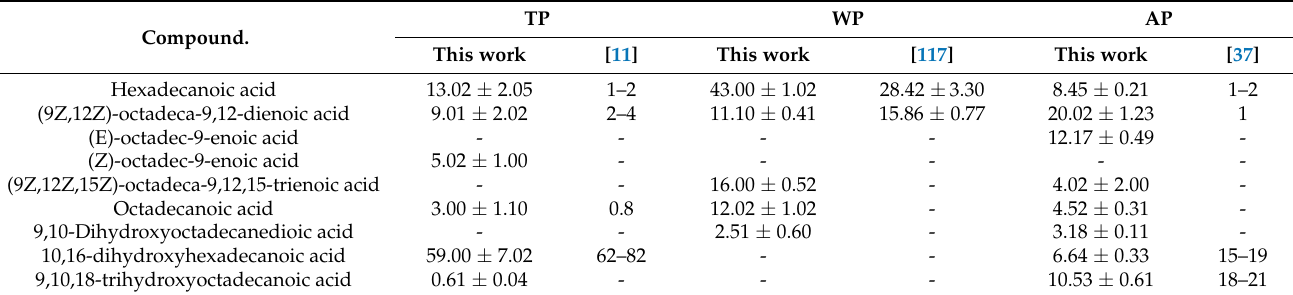
Table 5. Main cutin monomers obtained from tomato, watermelon and apple peels, expressed as percentage of total peak areas in the GC/MS chromatogram, and comparison with data reported in literature. Mean ± SD